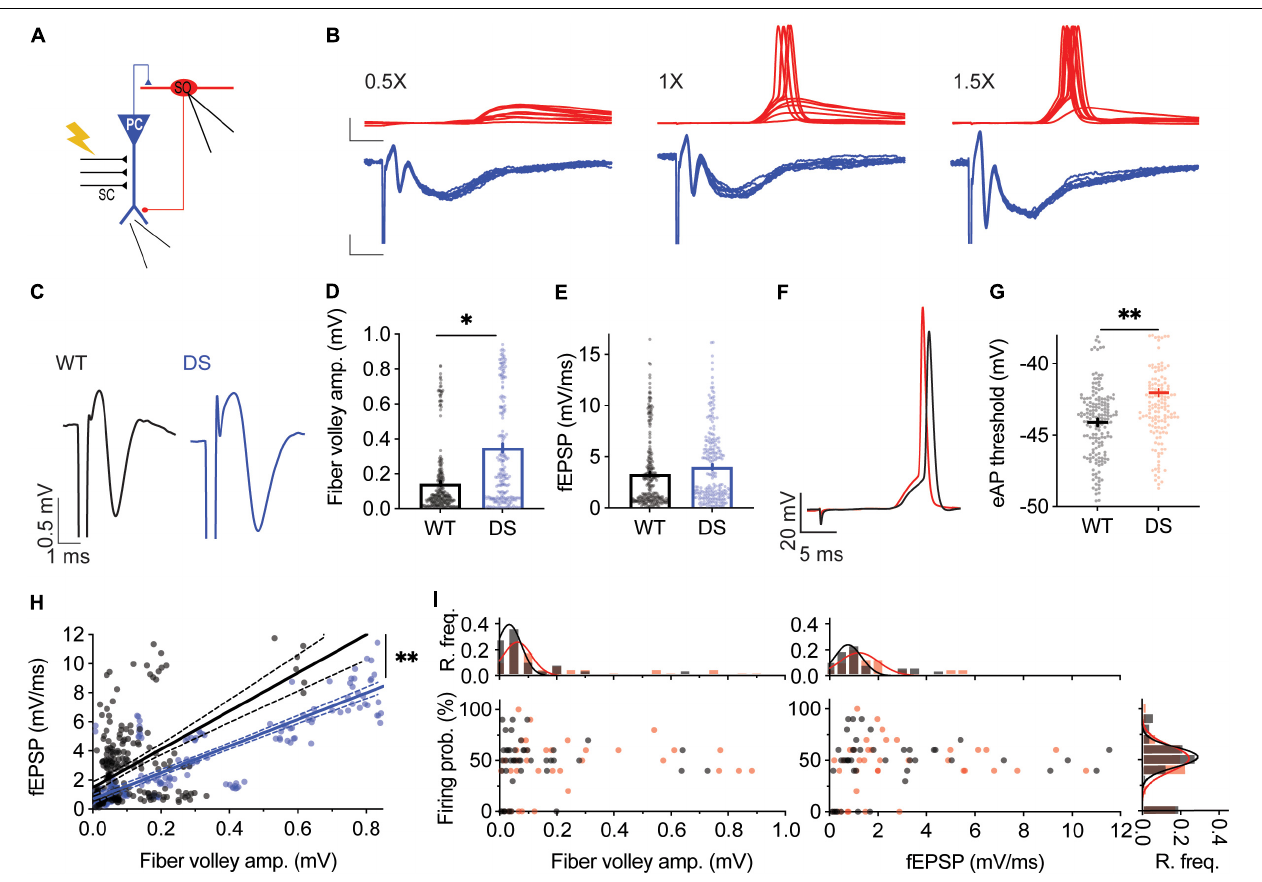
FIGURE 3 | Preserved firing of DS Scn1a A1783V / WT SO interneurons in response to CA3 stimulation. (A) Illustration of the experimental setup. The stimulating electrode was placed on the CA3, with extracellular field potentials recorded from CA1 pyramidal neurons (blue), concomitantly with whole-cell recordings of a SO interneuron (red). (B) Representative traces of field potential of CA1 pyramidal neurons (blue) and whole-cell recording of a SO interneuron (red) at different stimulation intensities. Left: low stimulation intensity (0.5X) that produced subthreshold responses in the recorded SO interneuron. Middle: intermediate stimulation intensity (1X) that produced firing probability of 50%, i.e., 5 AP and 5 EPSPs out of 10 stimulations at 1 Hz. Right: stronger stimulation intensity (1.5X), that produced firing probability of 90% in the recorded SO interneuron. Scale bar: top: 20 mV, 5 ms; bottom: 0.2 mV, 5 ms. (C) Representative traces of WT (black) and DS (blue) field potentials. (D,E) Average fiber volley amplitudes (D) and fEPSP (E) in recordings at which the firing probability of SO interneurons was 50% (1X). Statistical analysis utilized Mixed Model Analysis of Variance. (F) Representative traces of WT (black) and DS (red) synaptically evoked APs (eAPs) recorded from SO interneuron. (G) Average eAP threshold of WT and DS SO interneurons. Statistical analysis utilized Mixed Model Analysis of Variance. (H) Linear regression analysis of fEPSP slope vs. fiber volley amplitude. The solid lines represent the linear fit, and the dashed lines depict the 95% confidence interval. The fitted equation was Y = 13.14*X + 1.4 for WT ( R 2 = 0.33) and Y = 9.14*X + 0.67 in DS ( R 2 = 0.72). The statistical difference between the slopes is presented ( p = 0.0052). We repeated this analysis by fitting a non-linear exponential model to the data. The goodness of the fit was: WT: R 2 = 0.33, DS: R 2 = 0.77, and the statistical difference between the curves was p < 0.001. (I) SO interneurons firing probability vs. fiber volley amplitude or fEPSP. R.freq: the relative frequency histograms and Gaussian fit (solid line) of fiber volley amplitude, fEPSP or SO firing probability in WT and DS. WT: 28 cells from 11 mice; DS: 23 cells from 7